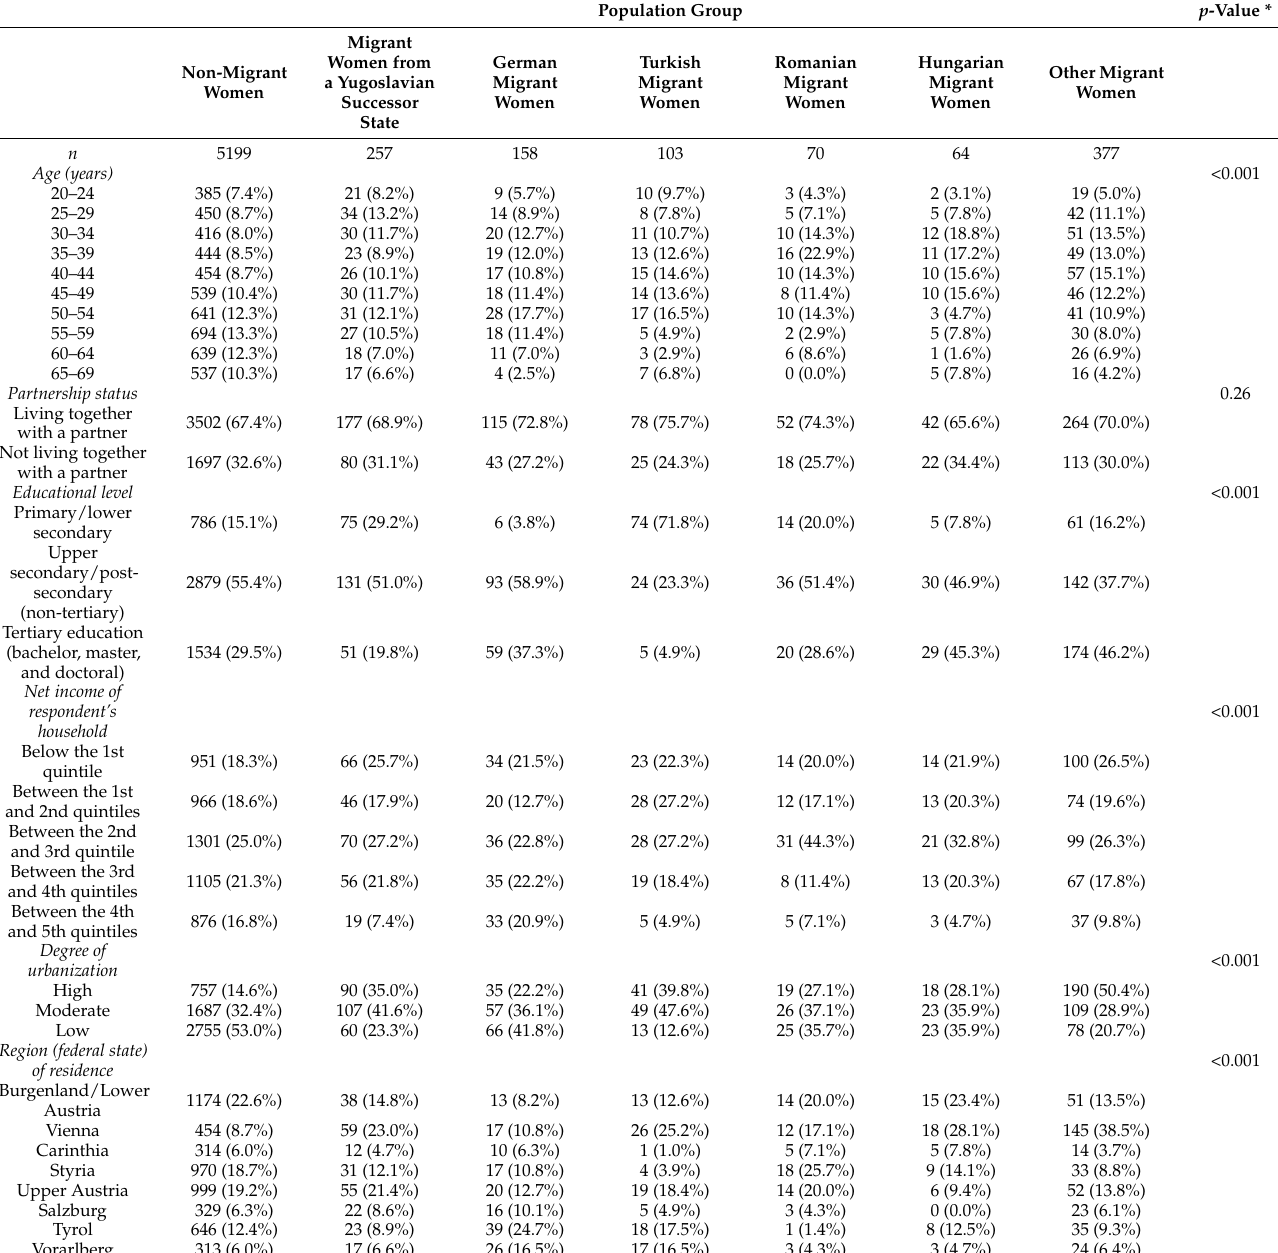
Table 1. Description of the study sample by population group (Austrian Health Interview Survey 2019; women aged 20–69 years, n =